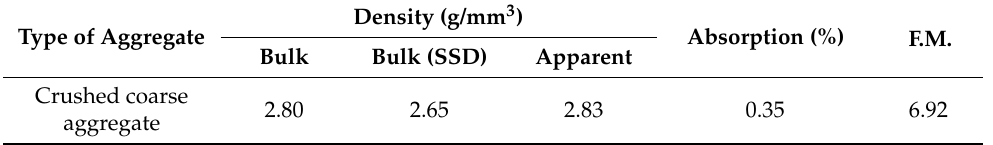
Table 5. Physical properties of the coarse aggregate.